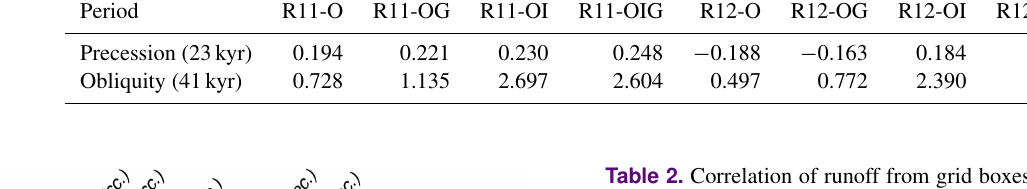
Table 2. Correlation of runoff from grid boxes 11 and 12 with the sedimentary records at Sites 967 and 659. Correlation is performed over the full period from 3.2 to 2.3Ma, and all data are interpolated on a 1kyr time